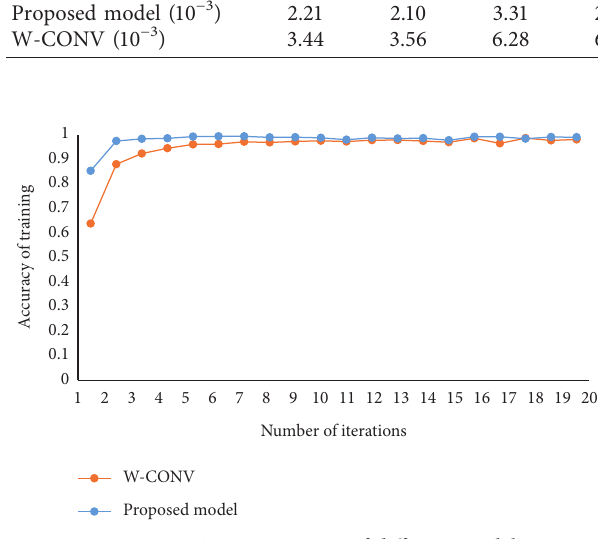
Figure 12: Training process of different models.